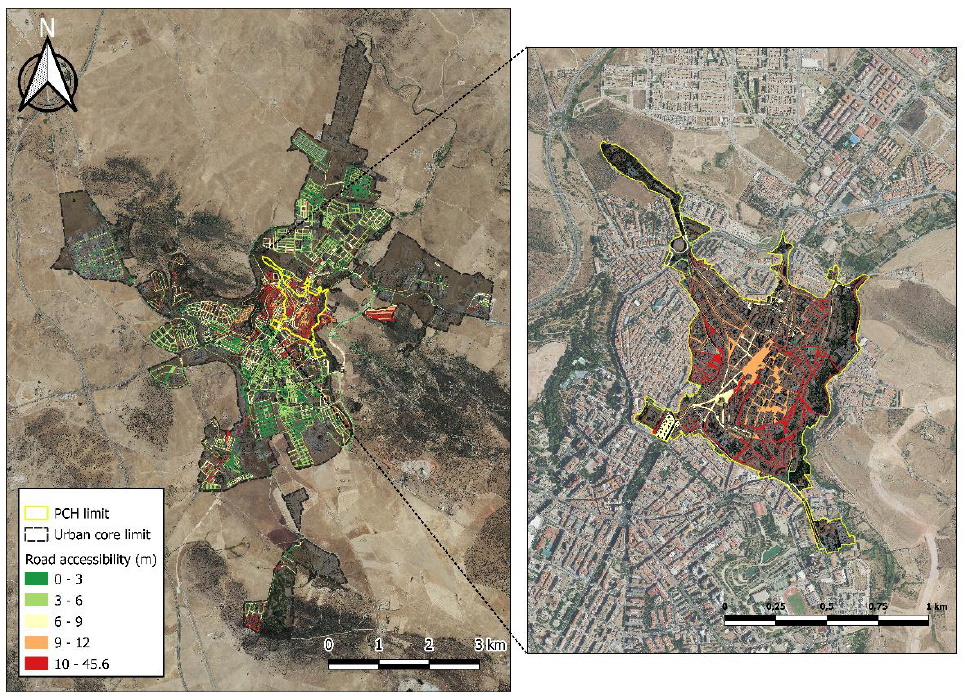
Figure 9. Road accessibility comparison.